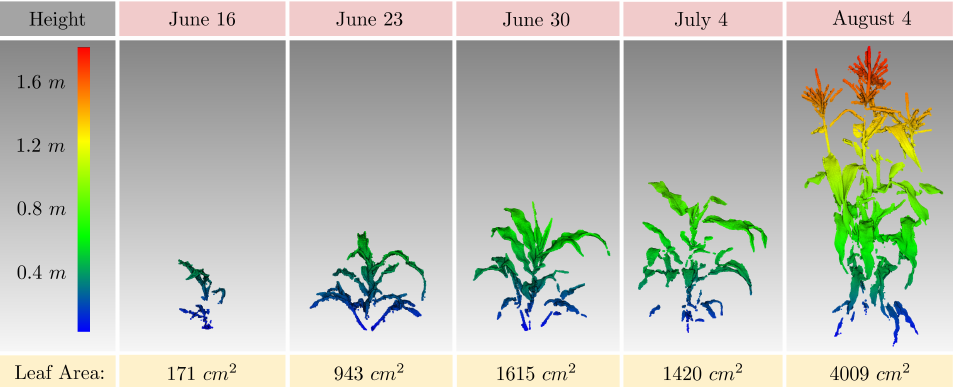
Figure 14. Estimated heights and leaf area for the multi-temporal data set of a single maize plant at five different days in the growing